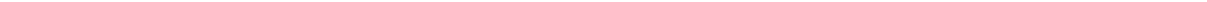
Fig. 4 MD simulations of the CTD – SP1 hexamer. a Clustering analysis of the MD trajectory of CA – SP1 WT (left) and CA – SP1(T8I) mutant (right) identi fi ed six major sub-populations. One chain is colored in blue (CA – CTD) and green (SP1) to illustrate the differences in secondary structure present in the SP1 region: predominantly random coil in CA – SP1 WT and signi fi cantly increased helical content in CA – SP1(T8I). b Stride plots of secondary structure for each chain along with the MD trajectories for CA CTD – SP1 WT (top), and CA CTD – SP1(T8I) mutant (bottom). c Helix/coil probability of the CTD tail (V221- end)SP1 subdomain averaged over the MD trajectories: CTD – SP1 WT (top) and CTD – SP1(T8I) (bottom). The expanded scale (0 – 0.05; right hand side) is shown for the “ Sheet ” content. b , c The CTD tail (V221-end)SP1 region exhibits a dynamic equilibrium between random coil and helical conformations in CA CTD – SP1 WT, whereas in the CA CTD – SP1(T8I) mutant the dynamics are greatly attenuated and the helical content is increased. d Correlation of MAS NMR chemical shifts and SHIFTX2-predicted shifts from the MD trajectory seeded from the X-ray structure (PDB: 5I4T): CTD – SP1 WT (left) and CTD – SP1 (T8I) (right). Note the remarkable agreement between the experimental and predicted shifts, indicating that the MD simulations accurately capture